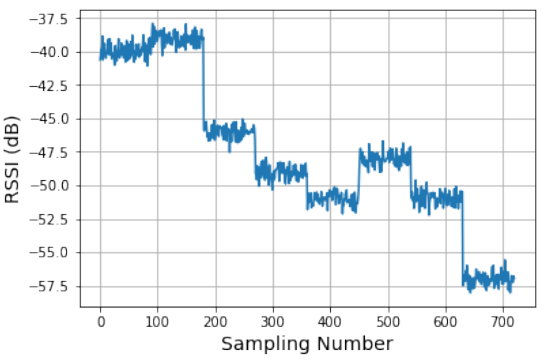
Figure 9. Simulated RSSI samples at each of